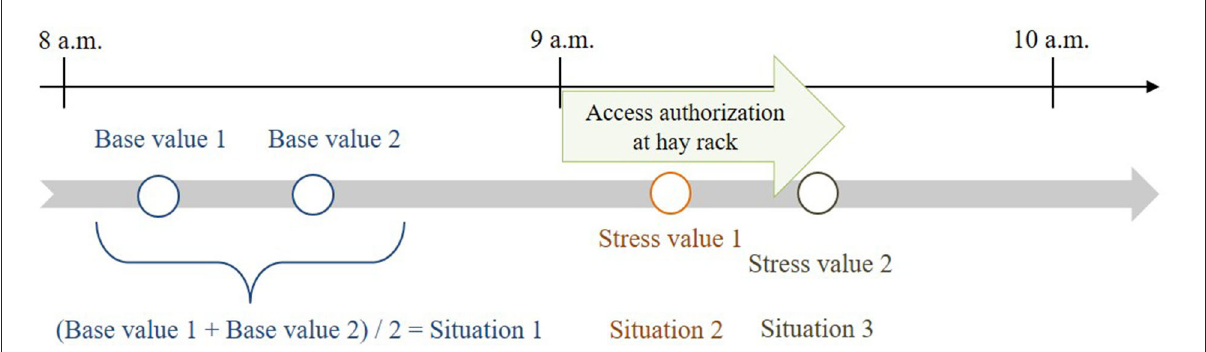
FIGURE3 Times of salivary cortisol sampling in relation to feeding times (feeding phase: access authorization at the time-controlled hay racks).